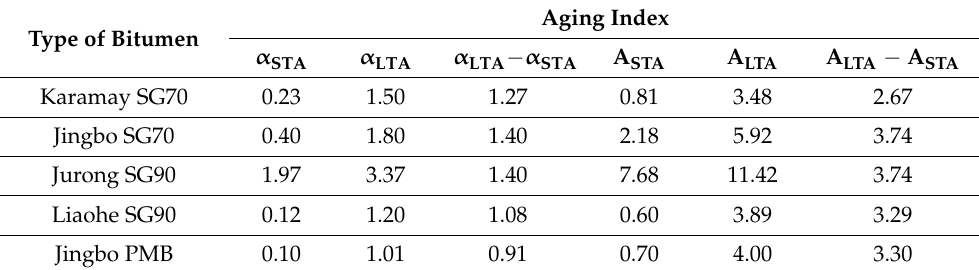
Table 6. The horizontal shift factor and deviation area of various bitumen binders. Type of